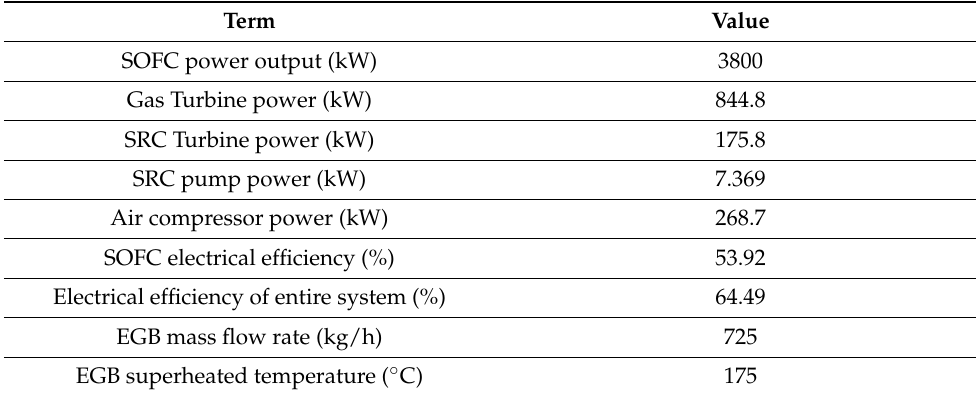
Table 5. Performance of integrated system.